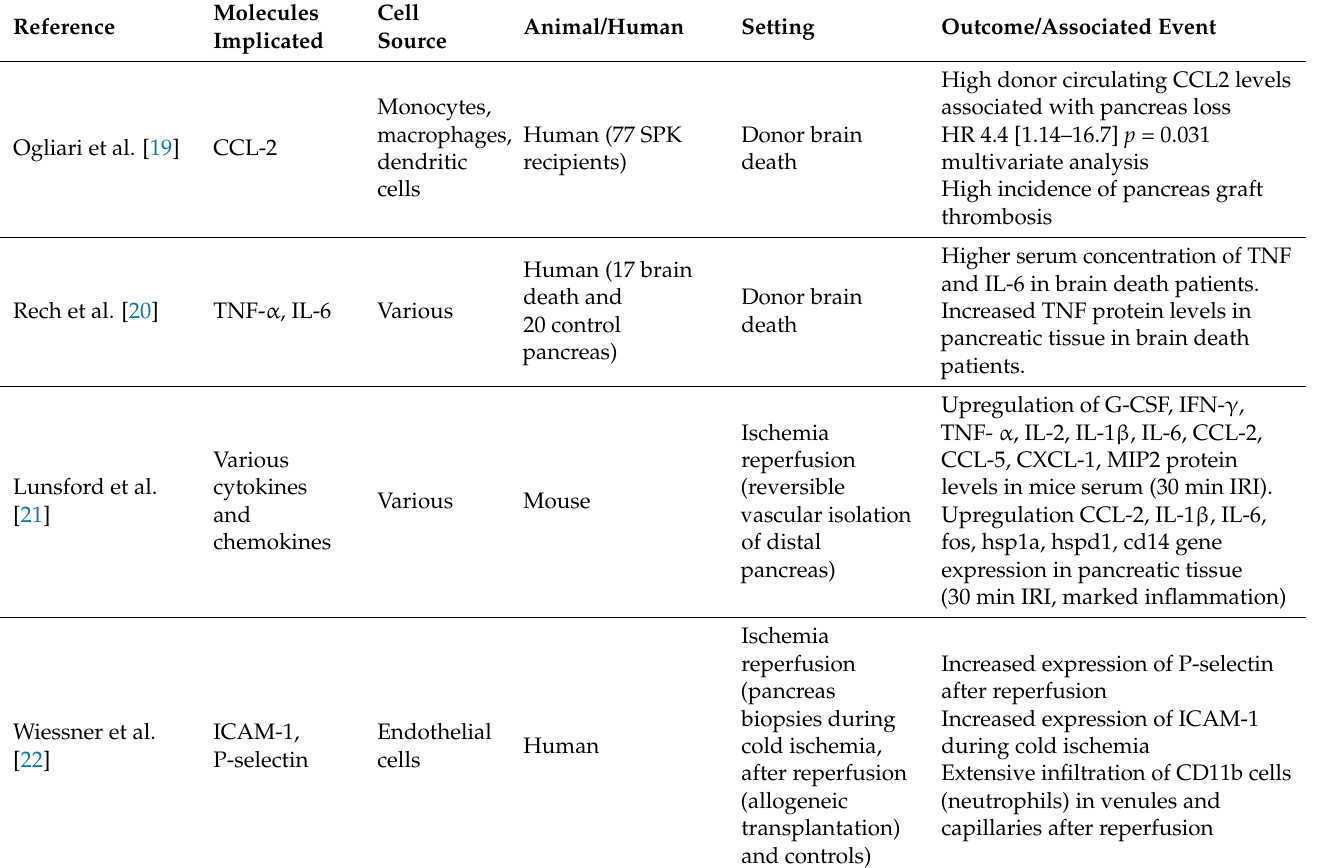
Table 2. Molecules implicated in pancreatic ischemia/reperfusion injuries and sterile